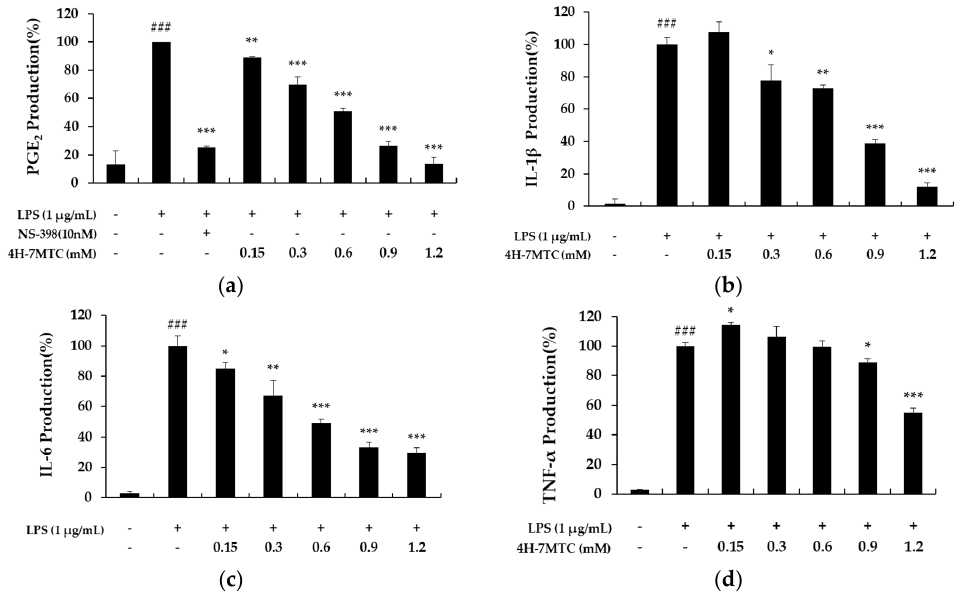
Figure 4. The effect of 4-hydroxy-7-methoxycoumarin (4H-7MTC) on the LPS-induced production of proinflammatory cytokines in RAW264.7 cells. Cells were pretreated with 4H-7MTC (0.15, 0.3, 0.6, 0.9, and 1.2 mM) for 1 h and then stimulated for 20 h with LPS. The production of PGE 2 ( a ), IL-1 β ( b ), IL-6 ( c ), and TNF- α ( d ) were determined using ELISA. The data are presented as the mean ± SD. Statistical significance was assessed by one-way analysis of variance (ANOVA) followed by Tukey’s post-hoc test and represented as follows: Values are representative of three independent experiments. ### p < 0.005 vs. control cells. * p < 0.05, ** p < 0.01, *** p < 0.001 vs. LPS alone.